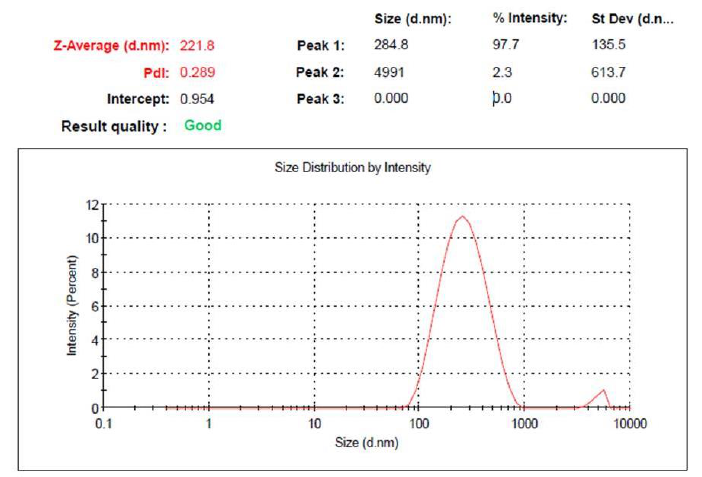
Figure 6. Particle size and PDI of optimized PEGylated Brucine liposomal formulation.